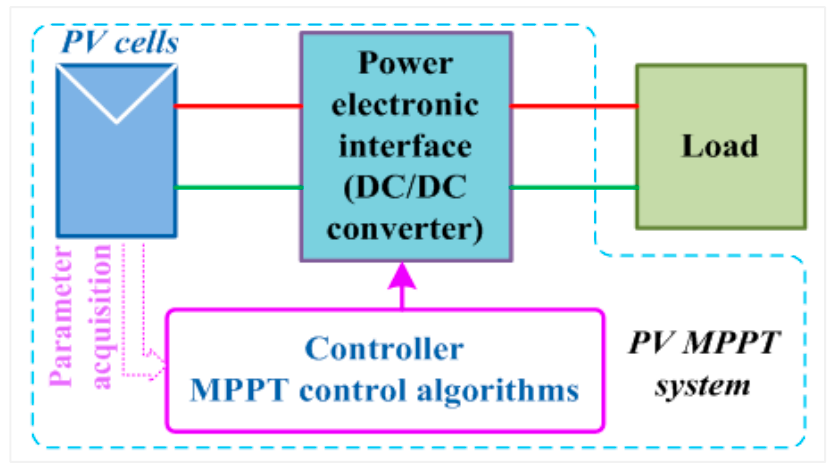
Figure 4. The block diagram of a general PV maximum power point tracking (MPPT) system.